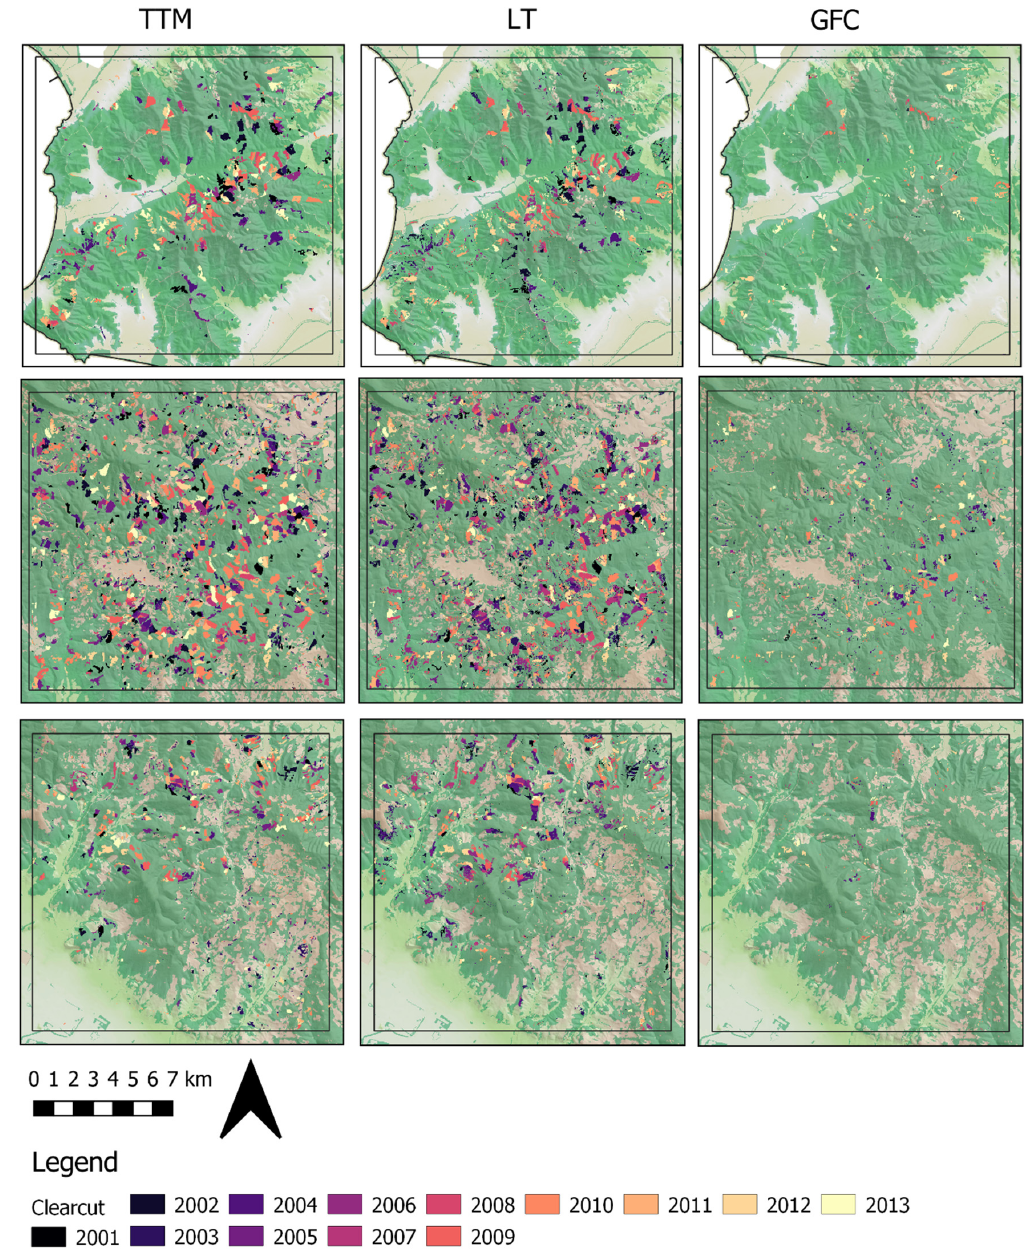
Figure 4. Clearcut maps estimated using TTM, LandTrendr (LT) and Global Forest Change Map (GFC) for the three areas where the reference validation dataset was available.